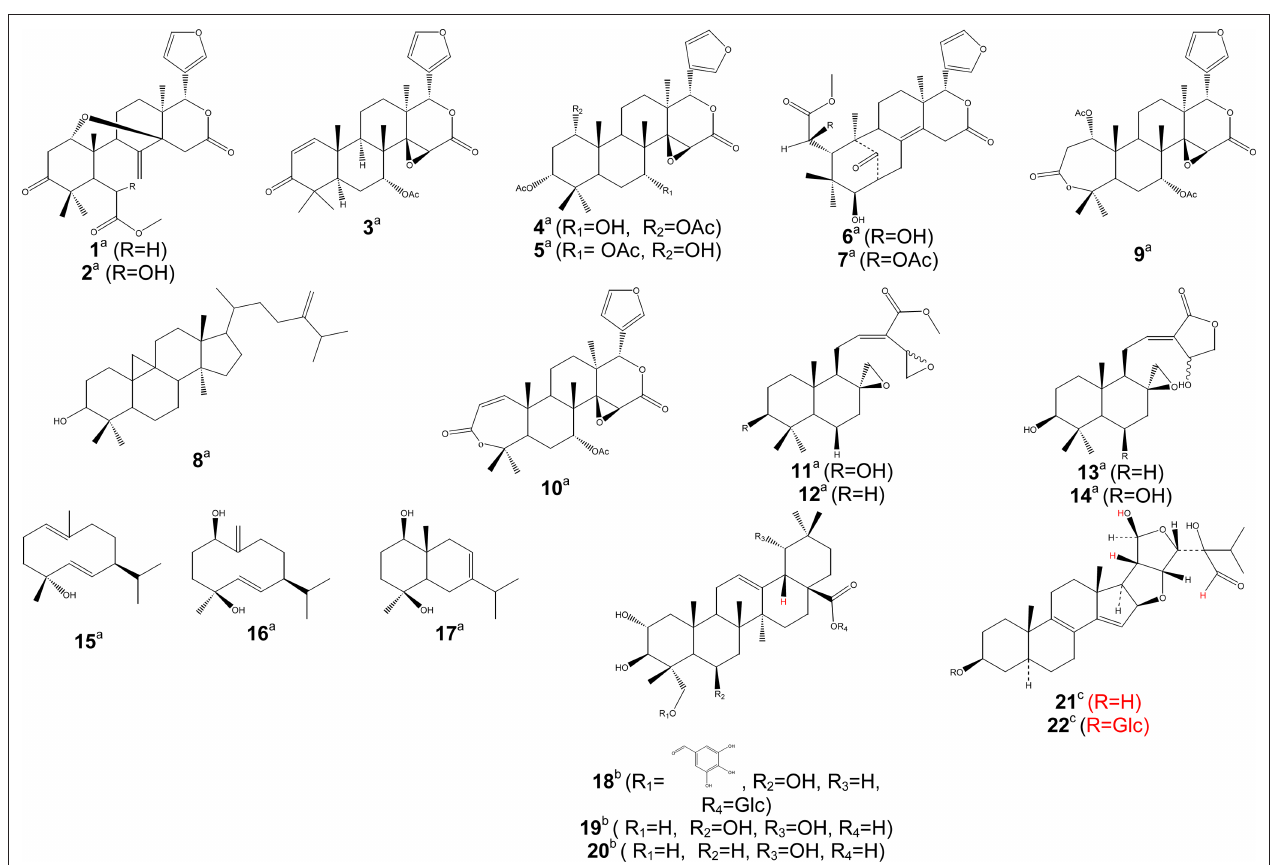
FIgUrE 2 | Bioactive terpenoids. Activity [(a) antimalarial, (b) anti-inflammatory, (c) antitrypanosomal]; Glc, glucosyl group; Ac, acetyl